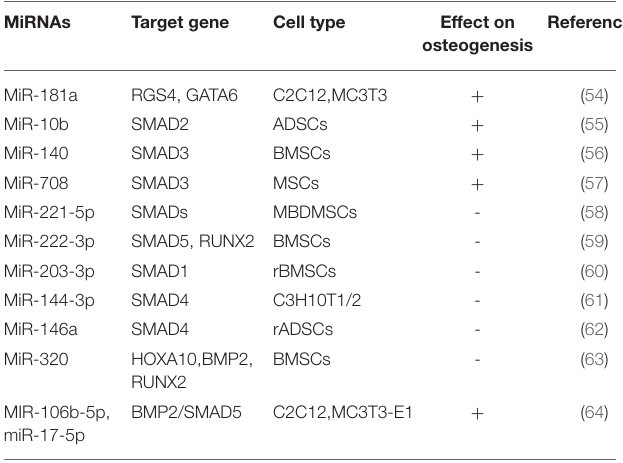
TABLE 2 | MiRNAs regulate osteogenic differentiation by TGF-ß/BMP signaling